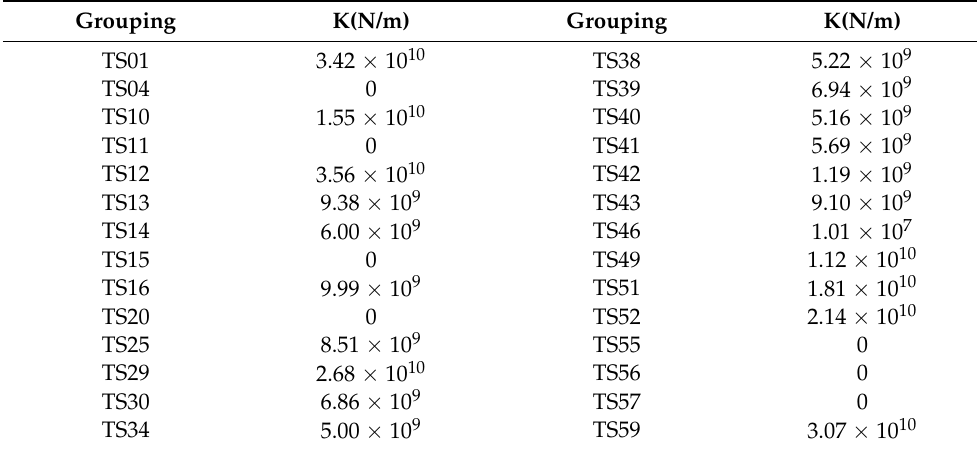
Table 2. Equivalent support stiffness of cracked boulders.